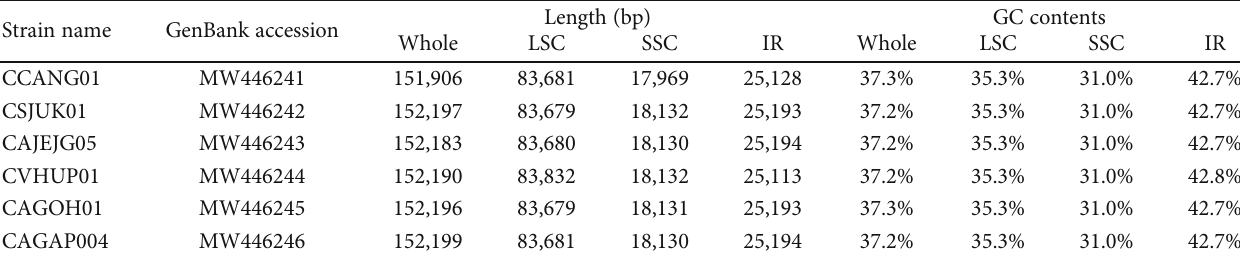
Table 2: List of six chloroplast genomes of Chenopodium album sequenced in this